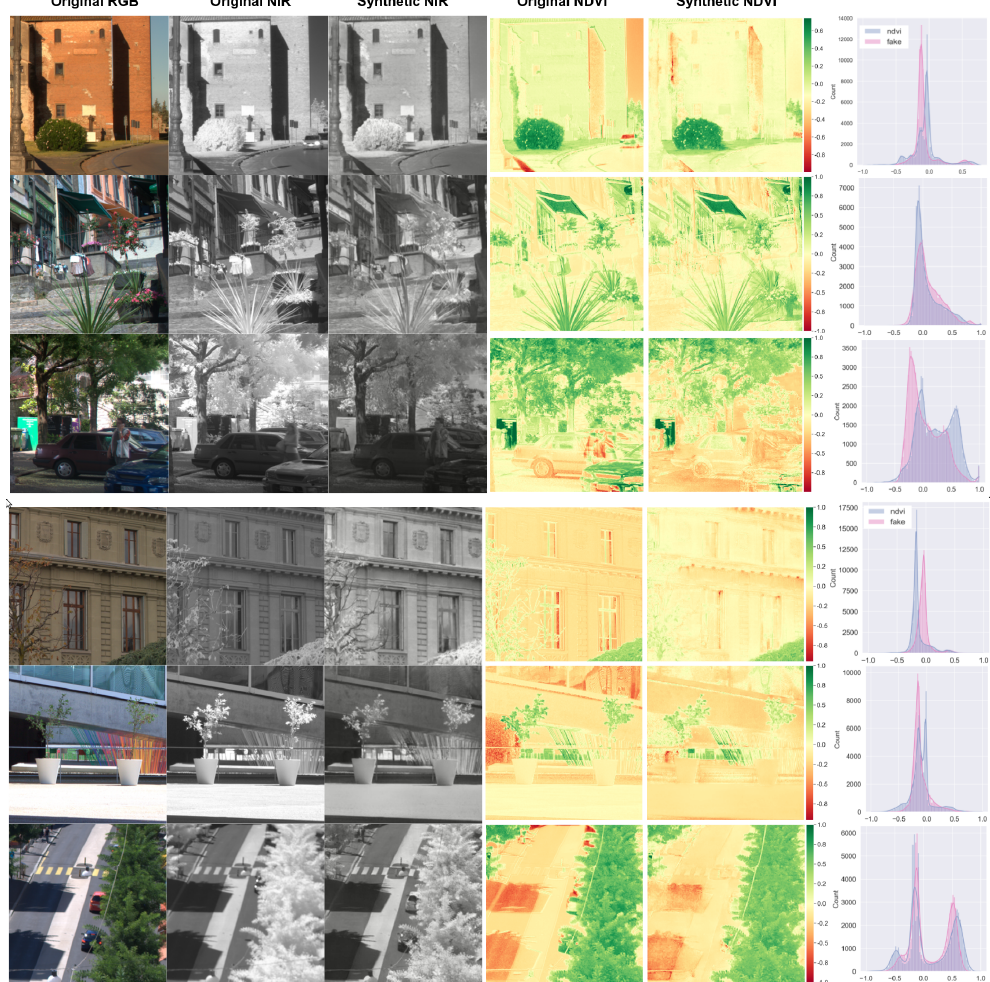
Figure 9. Six samples of nirscene1 dataset (1st and 2nd columns) and their corresponding synthetic NIR image (3rd) and NDVI images generated from original and synthetic NIR images (4th and 5th). The right most column shows pixel distribution for each NDVI images (red: synthetic, blue: original). The SEN12MS dataset was taken/calibrated in more stable conditions than